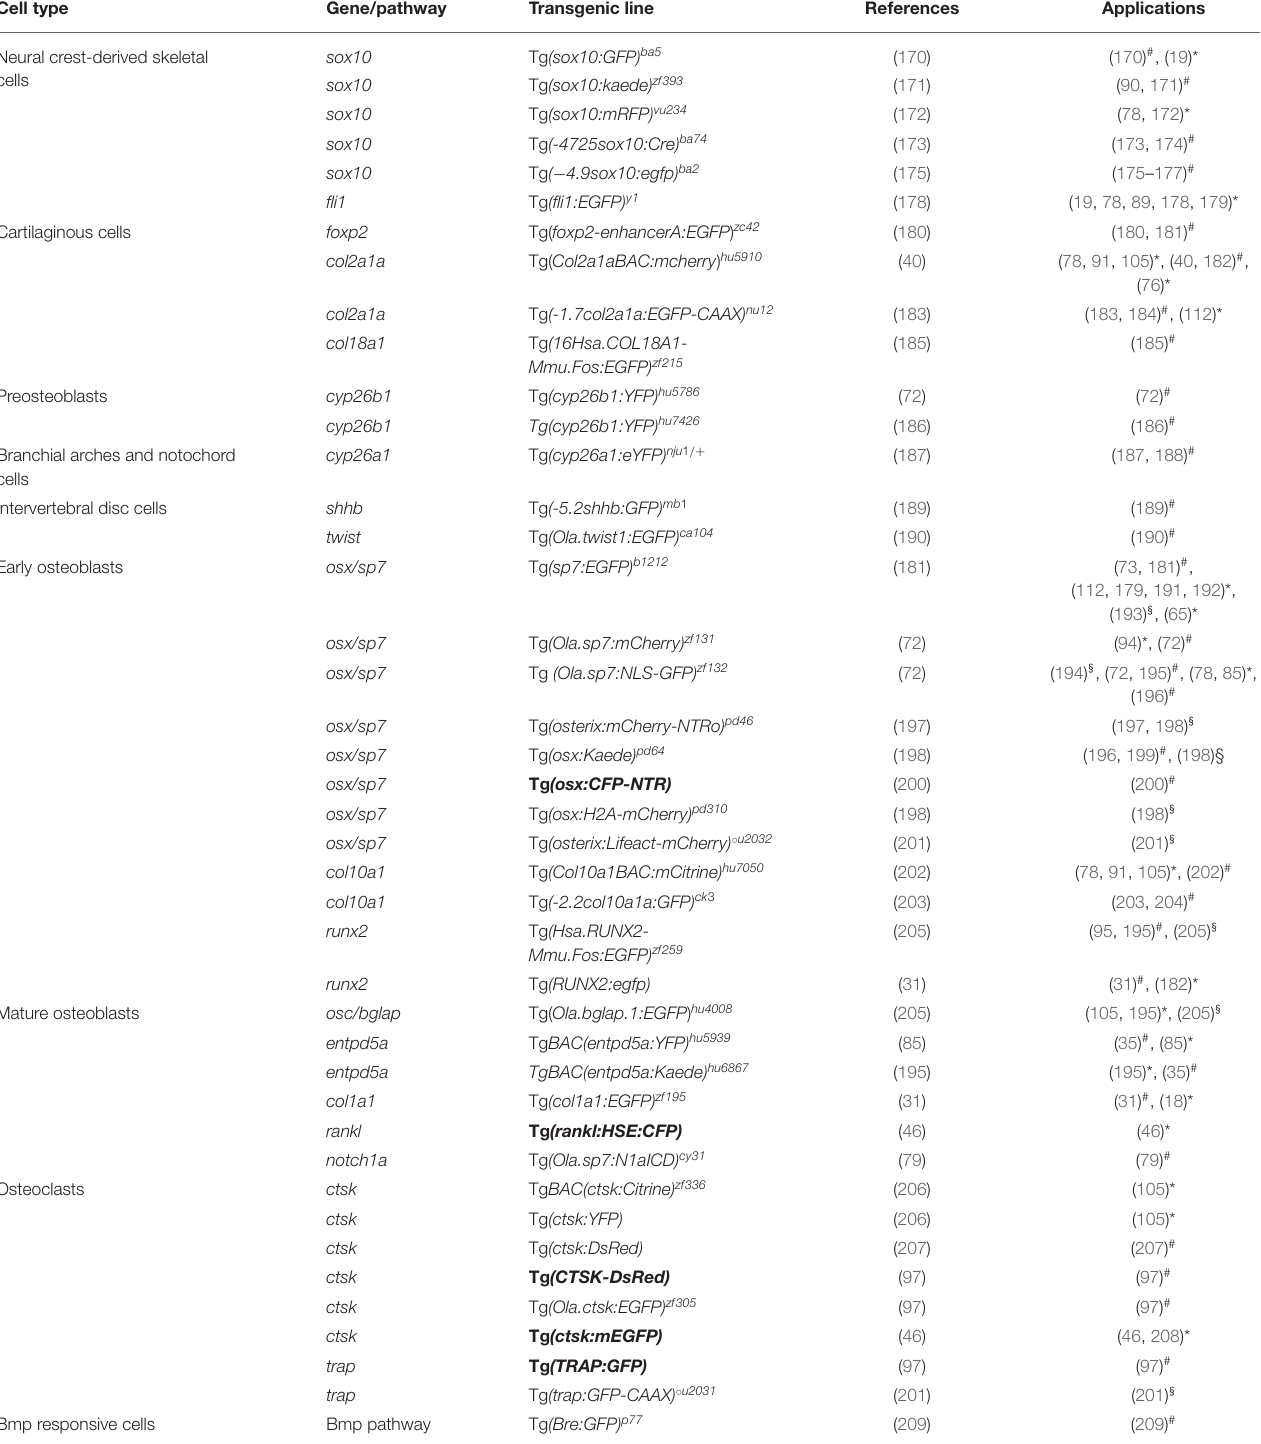
TABLE 2 | Transgenic lines employed to study zebrafish